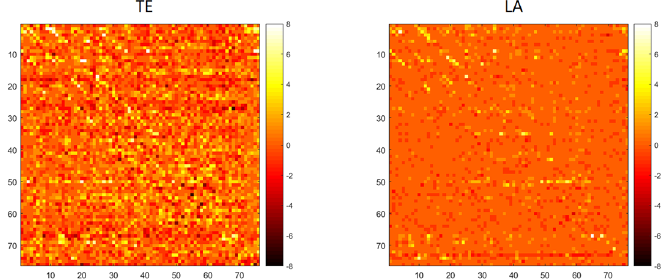
Fig 15. Results for an epileptic EEG recording. Matrices depict the difference of total numbers of significant connections between ictal and pre-ictal period (ict—pre). The numbers are respectively summed from 8 recordings. Contacts 1 to 64 belong to a cortical electrode grid, and contacts 65 to 76 to two depth electrode strips. The values are computed by traditional non-uniform transfer entropy (TE) and low-dimensional approximation approach (LA). The directions of causal influence are from row to column. The brighter colors correspond to more significant